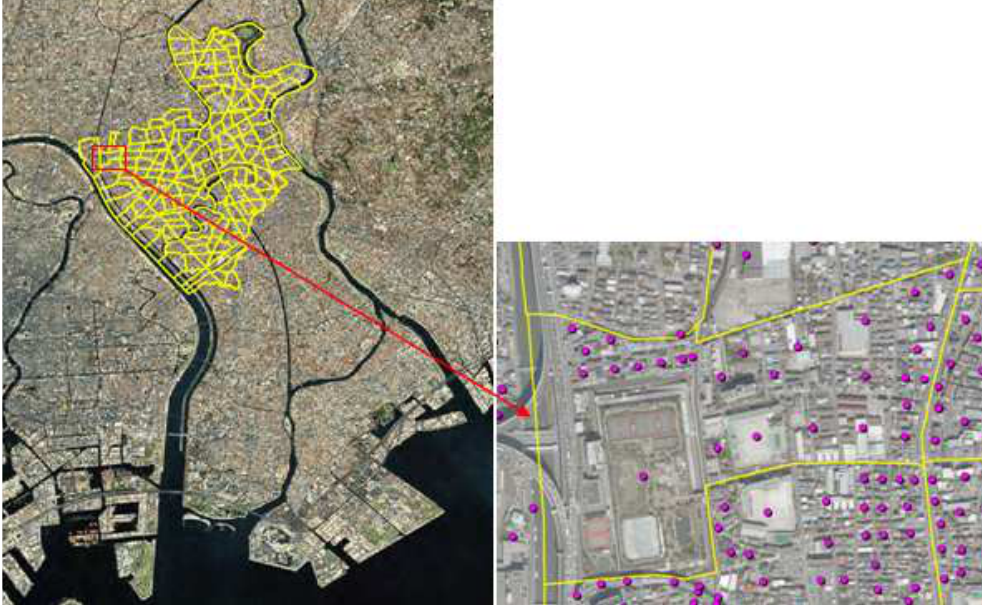
Fig 5: GIS files in Japanese address system. Left: Cho/Chome boundaries in Katsushika Ward; Right: Gaiku points in a selected Cho/Chome (adapted from National Statistics Center, National and Regional Planning Bureau)